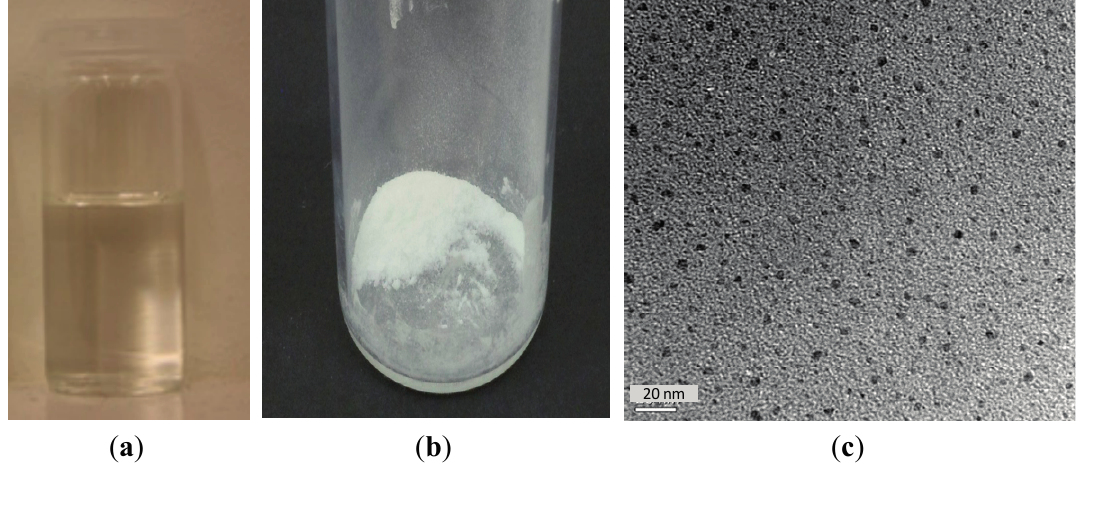
Figure 6. ( a ) Synthesized TiO image of dried TiO